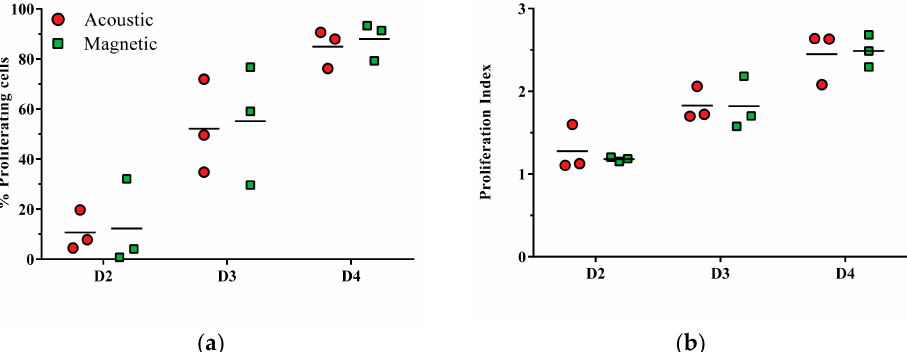
Figure 4. CD3/CD28-mediated T cell proliferation of acoustically and magnetically sorted CD8+ cytotoxic T cells. Cells were stimulated in the presence of anti-CD3/CD28 and proliferation was measured on days 2, 3 and 4 of culture using CFSE staining ( n = 3). For each day the relative number of proliferating cells ( a ) as well as the proliferation index, i.e. , the average number of cell divisions all responding cells have undergone, are presented ( b ).